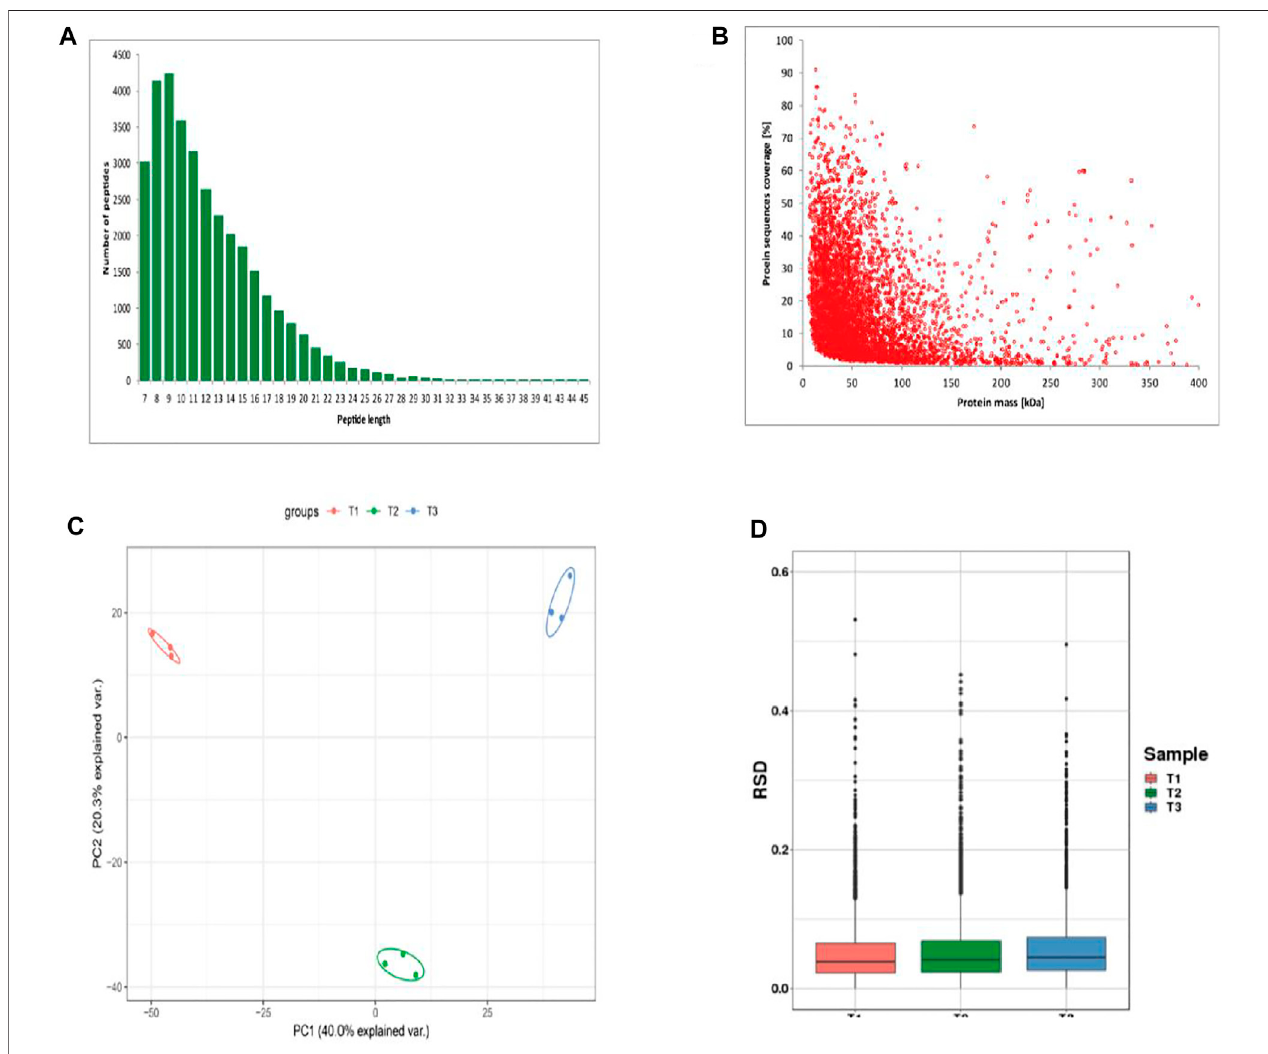
FIGURE2| Identi fi cationofproteinsofskinsfromZhongweigoats (A) Peptidelengthdistribution. (B) proteinsequencecoveragedistribution. (C) Two-dimensional scatter plot of quantitative principal component analysis of protein among samples. (D) Box plot of quantitative RSD distribution of protein among samples.